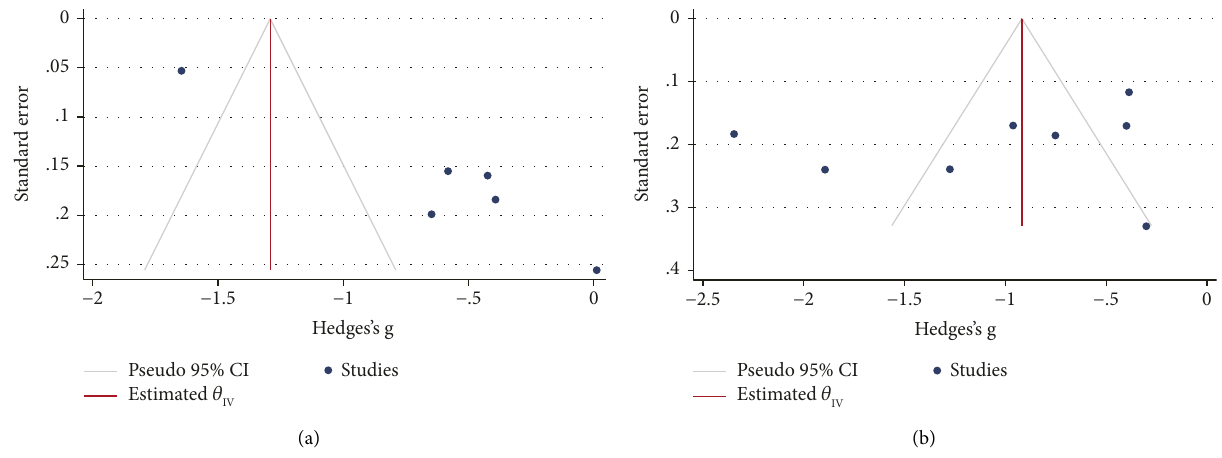
Figure 7: Funnel plots assessing publication bias among studies; (a) Studies on infection; (b) Studies on SBP.